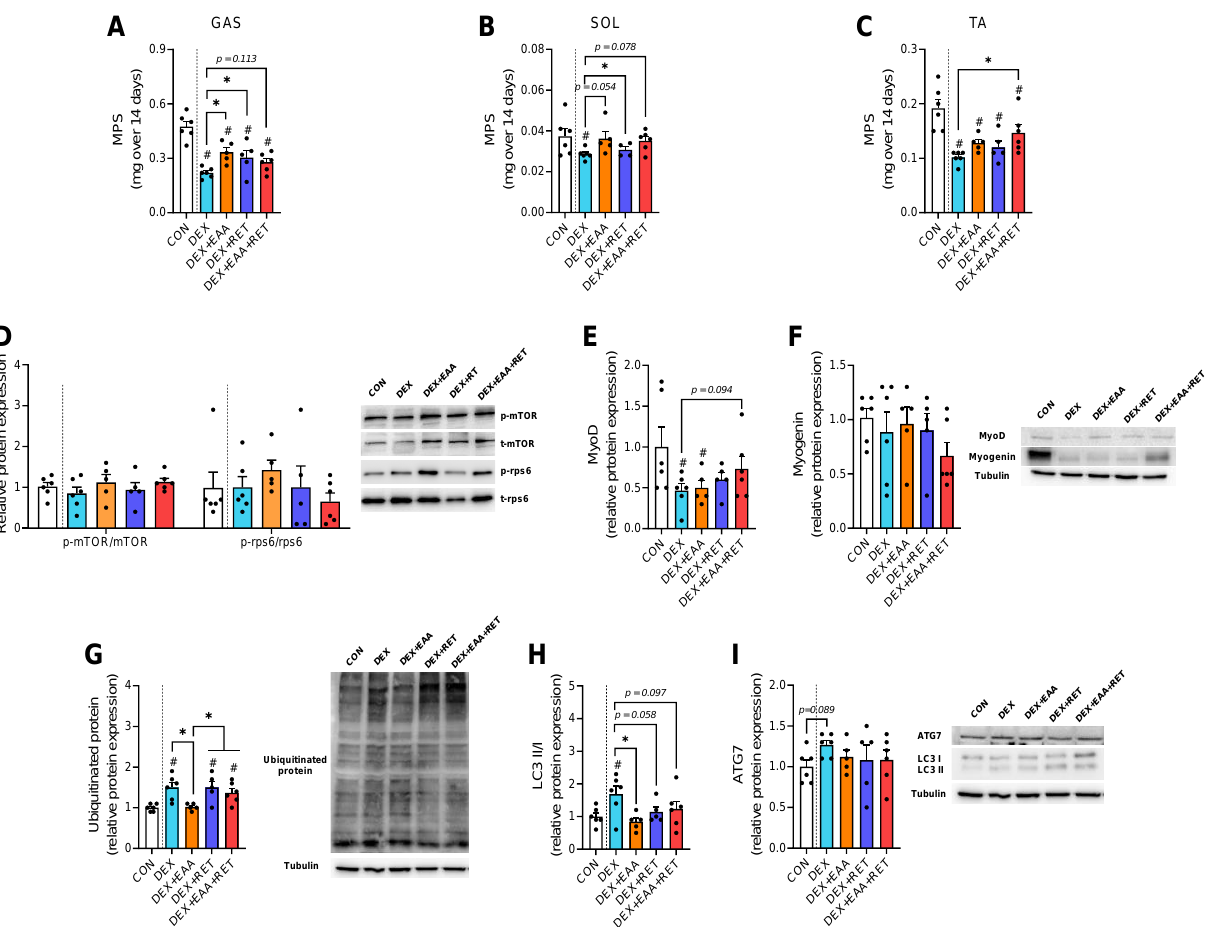
Figure 2. EAA and/or RET stimulate muscle protein synthesis rate and suppression of autophagy activation in muscle of DEX-treated mice. Integrated myofibrillar protein synthesis rate in ( A ) gastrocnemius muscle (mixed muscle), ( B ) soleus muscle (slow oxidative muscle), and ( C ) tibialis anterior muscle (fast glycolytic muscle) for 14 days (n = 5–6 per muscle type). ( D ) Representative image and relative protein expression of mTOR and rps6 in gastrocnemius (n = 5–6). Representative image and relative protein expression of ( E ) MyoD and ( F ) myogenin in gastrocnemius (n = 5–6). ( G ) Representative image and relative protein expression of ubiquitinated-protein in gastrocnemius (n = 5–6). ( H ) Representative image and relative protein expression of the ratio of LC3B II/I and (I) ATG7 in gastrocnemius (n = 5–6). Data are presented as mean ± S.E. # Significant difference from control group (p < 0.05). * Significant difference between labeled groups ( p < 0.05). CON, sedentary control; DEX, dexamethasone; EAA, essential amino acids; RET, resistance exercise training; MPS, myofibrillar protein synthesis; mTORC1, mammalian target of rapamycin complex 1; rps6, ribosomal protein s6; MyoD, myoblast determination protein 1; LC3, microtubule-association protein 1A/1B-light chain 3; ATG7, autophagy-related 7; GAS, gastrocnemius muscle; SOL, soleus muscle; TA, tibialis anterior muscle.